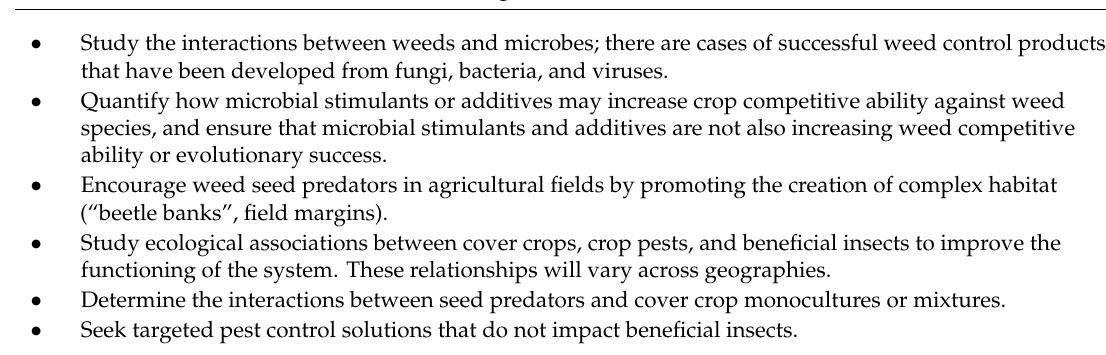
Table 1. Cont. Biological Weed